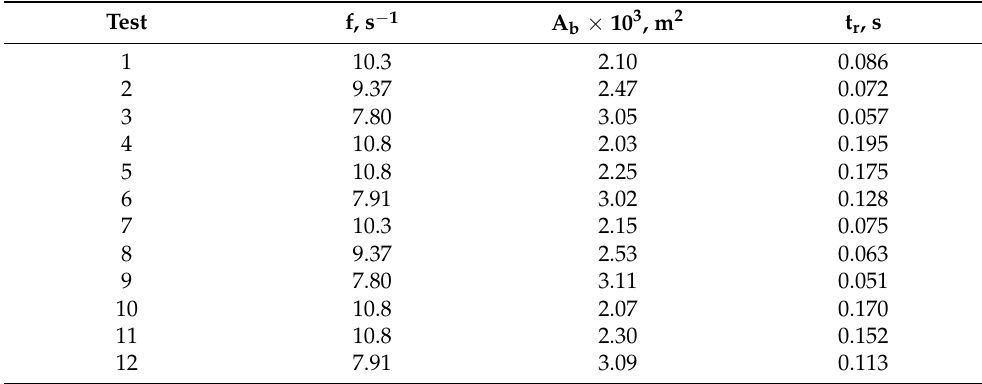
Table 3. Characteristics of the bubbles injected into the molten white metal during the conversion experiments described in Table 1.